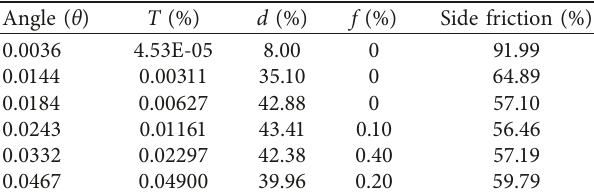
Figure 18: Bending moment distribution between joint areas. (a) Rotated joint and (b) moment contribution of each area. Table 5: Percentage of bending moment contribution from each